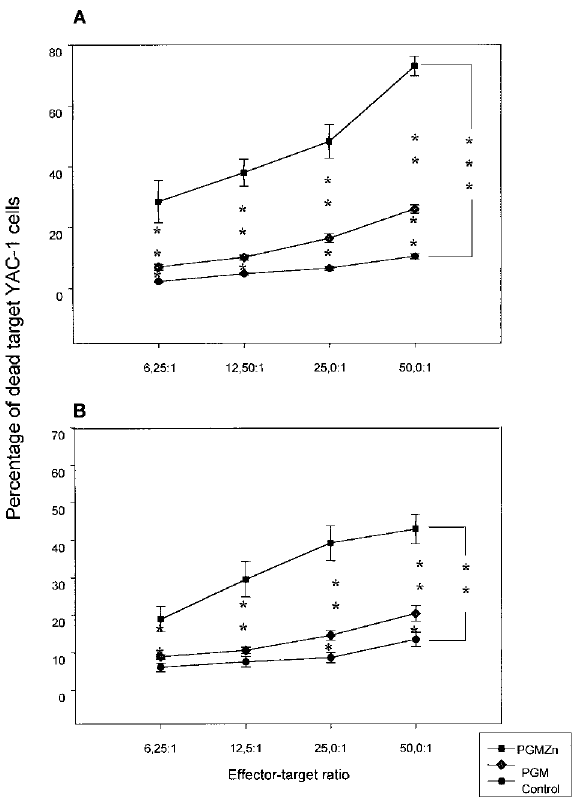
FIG. 5. Destruction of labeled syngeneic target cells by hepatic (A) and splenic (B) MNLC obtained from mice pretreated with PGM-Zn or saline solution. Results are presented as mean ± standard error ( n = 7). * p < 0.05, ** p < 0.01, *** p <